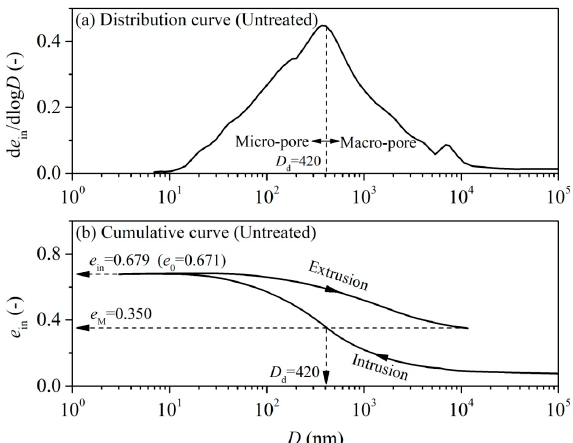
Figure 14. MIP results of saturated untreated and cement-treated GRSs cured to 28 d.